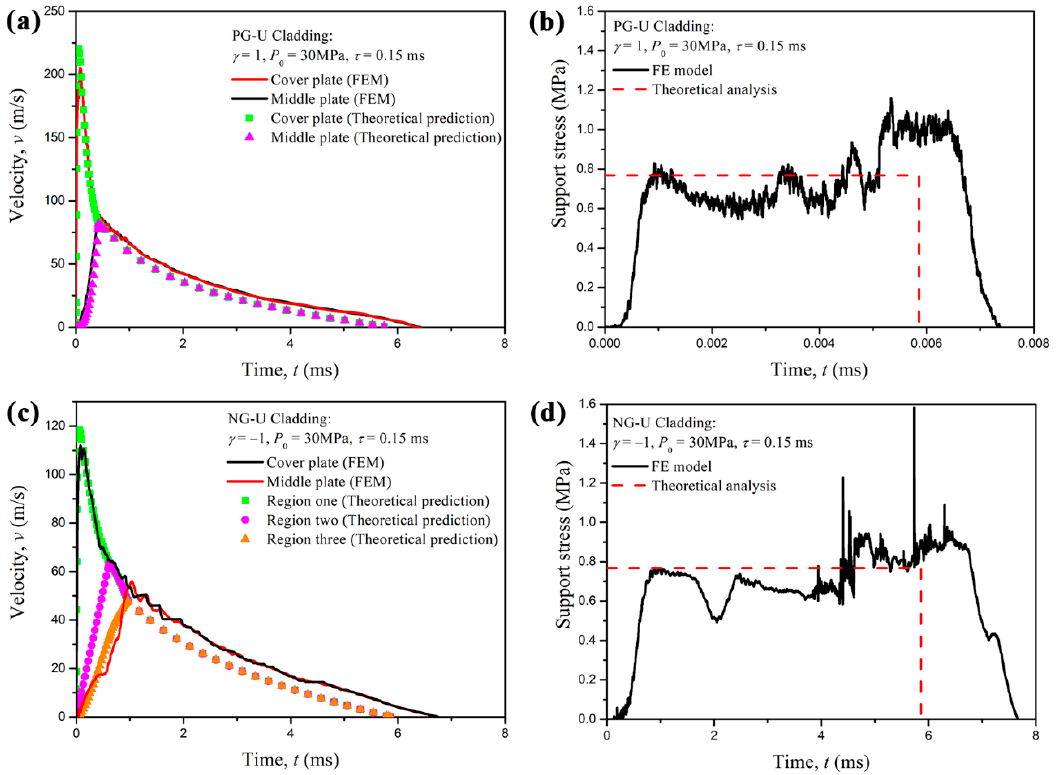
Figure 10. Comparison between cell-based FE results and theoretical predictions: ( a , b ) for PG-U cladding; ( c , d ) for NG-U cladding.